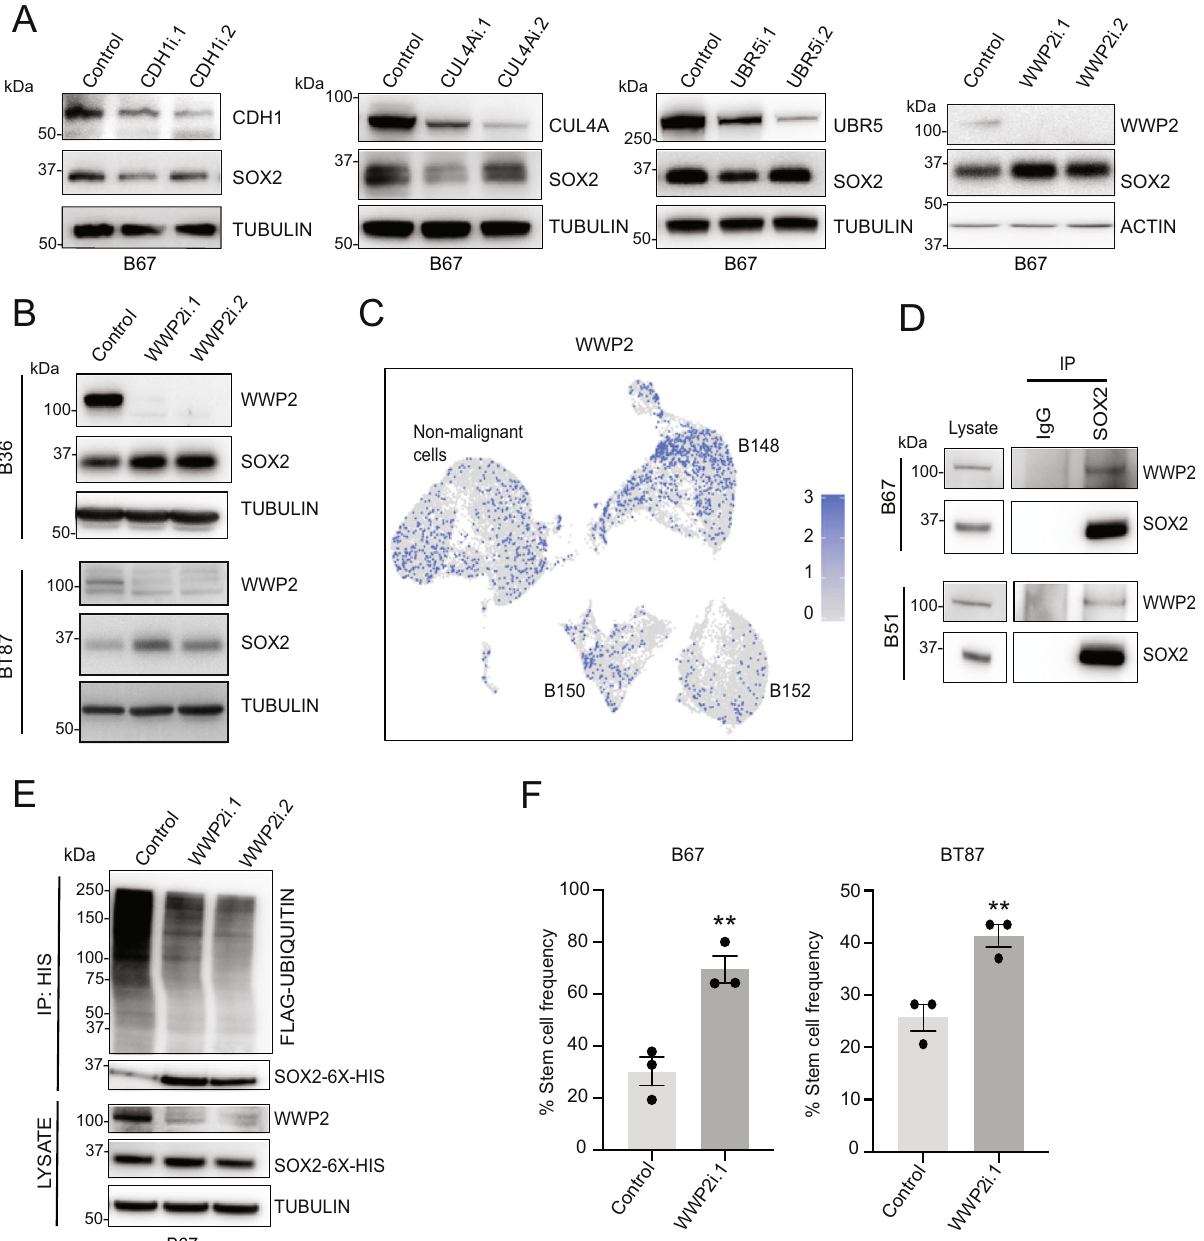
Fig. 4 WWP2 is a bona fi de SOX2 E3 ubiquitin ligase in GSCs. A GSCs transduced with control or RNAi targeting CDH1, CUL4A, UBR5, and WWP2 were harvested 6 days later and subjected to immunoblotting. Data were representative of three independent experiments. B GSCs transduced with WWP2 RNAi or control were harvested 6 days later and subjected to immunoblotting. Data were representative of three independent experiments. C Cells isolated from patient tumors were subjected to scRNA-seq. Malignant cells were identi fi ed by expression-based inference of copy number variation as in Fig. 1I. Cells are colored by expression level for WWP2. D GSC lysates were subjected to anti-SOX2 immunoprecipitation (IP). Input lysates and IP samples were subjected to immunoblotting. Data were representative of three independent experiments. E GSCs transduced with lentiviruses to stably express 6X- Histidine epitope-tagged SOX2 and FLAG epitope-tagged ubiquitin were transduced with WWP2 RNAi or control. Lysates were subjected to IP under denaturing conditions using nickel-NTA beads. IP and input samples were subjected to immunoblotting. Data were representative of three independent experiments. F GSCs transduced with WWP2 RNAi or control were subjected to ELDA as in Fig. 3A. Data represent mean ± SEM ( n = 3, unpaired t -test, ** P < 0.01). See Source Data File for exact P values and statistical